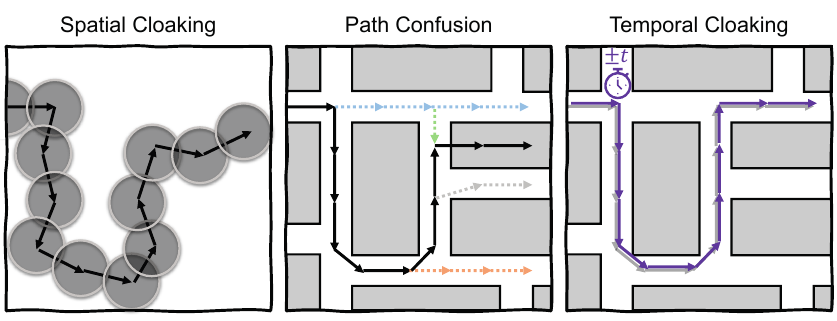
Figure 9. Visualization of Spatial Cloaking, Path Confusion, and Temporal